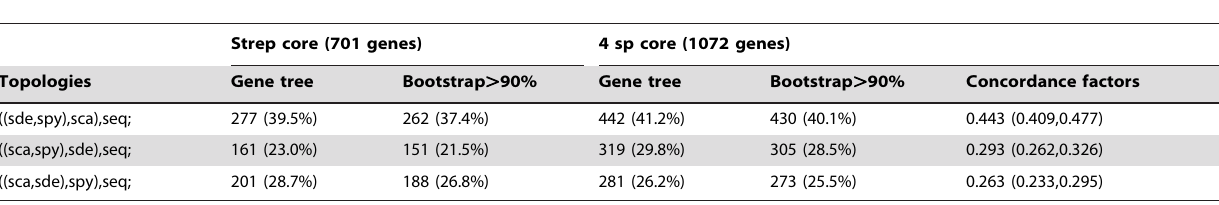
Table 2. Gene tree support and concordance factors for three concurrent species